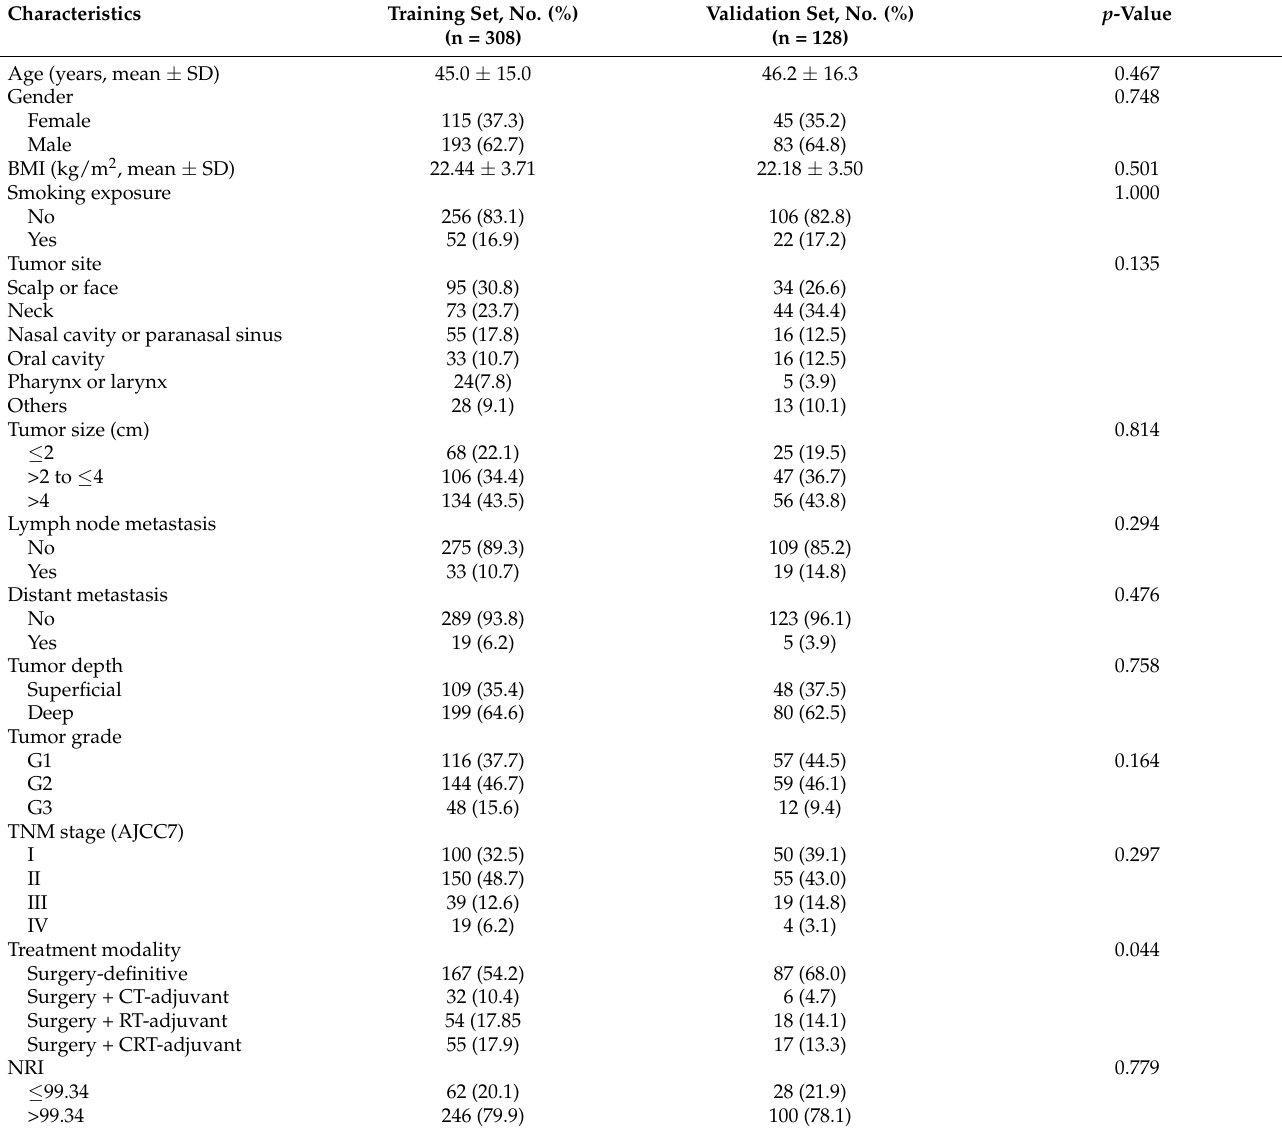
Table 2. The baseline characteristics in the Training and Validation